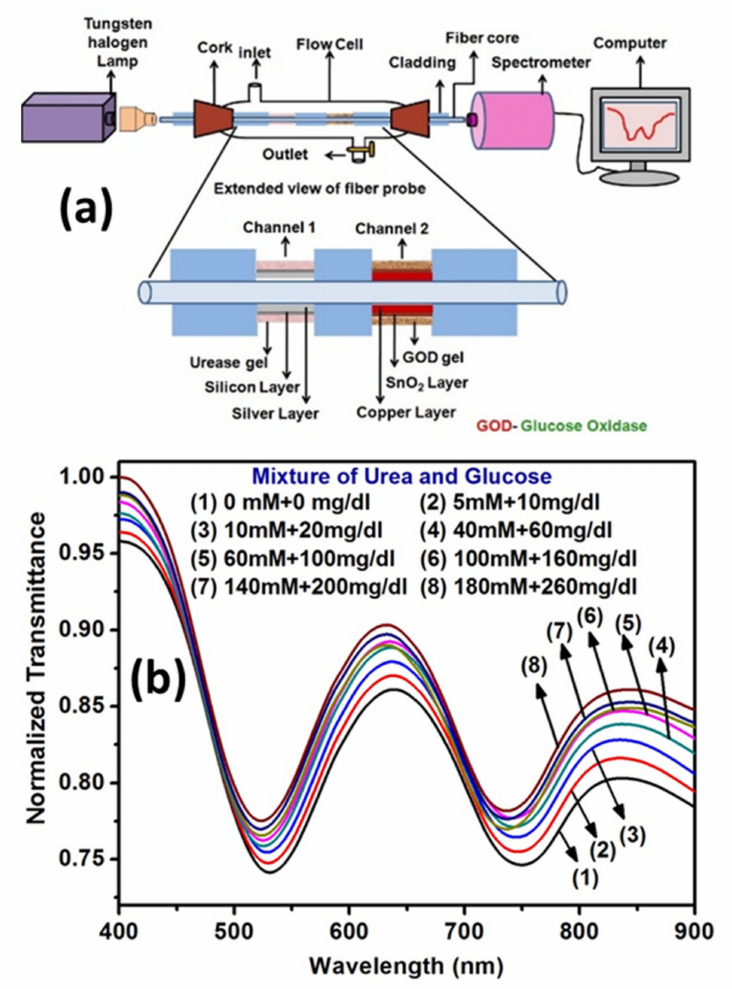
Figure 23. ( a ) Schematic representation of experimental set-up along with designed probe, and ( b ) SPR response for different concentrations of urea and glucose in the samples. Reprinted with permission from Ref. [133]. Copyright 2014 Royal Society of Chemistry.